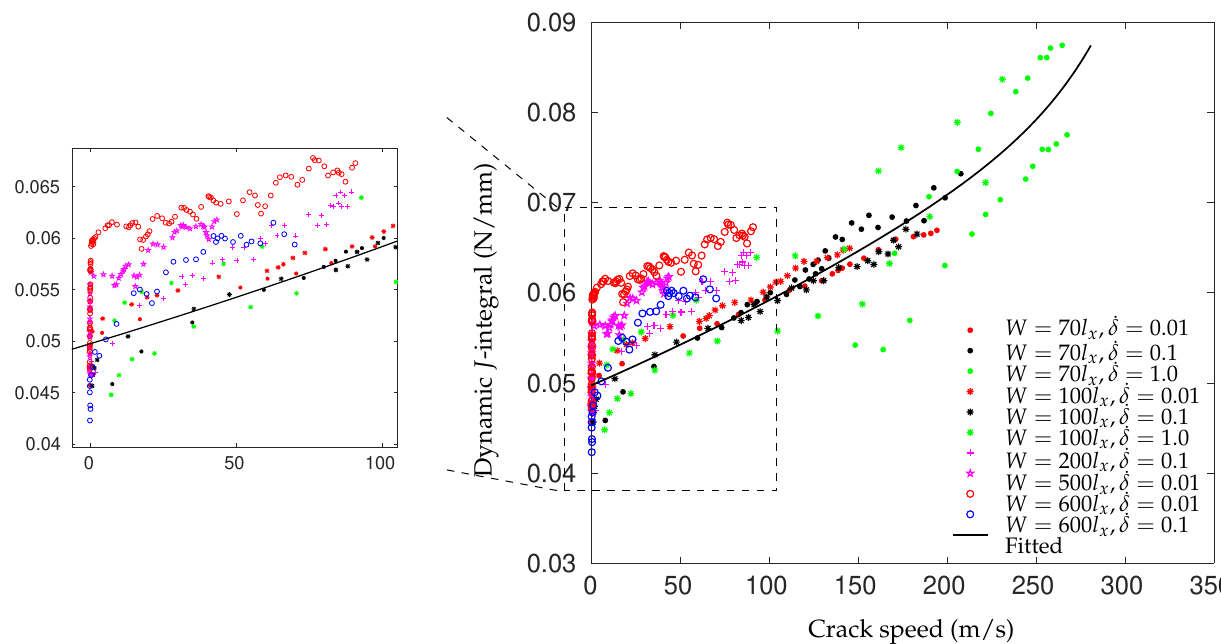
Figure 10. The dynamic J -integral for different crack speeds computed from the series of tests. A zoomed-in view of the lower crack speed range is shown on the left